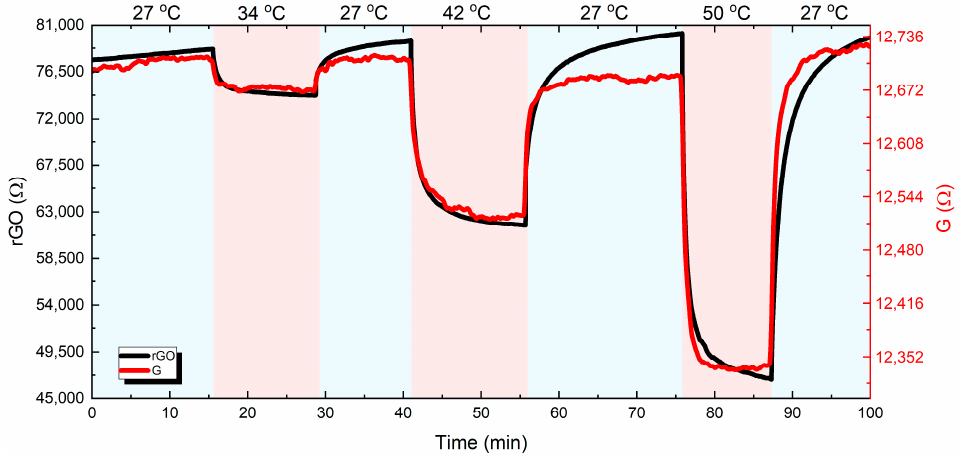
Figure 12. Graphene and f ‐ rGO transient response for three heating steps.